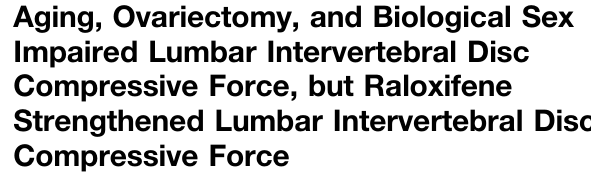
height bene fi t in female mice than in male mice, and increased nucleus pulposus area by 24% (F = 5, p < 0.05; Supplementary Figure S7 ). Compared with 24-month-old control IVD, injection of raloxifene reduced the lumbar age-related IVD degeneration score in old female mice by 57% ( p < 0.05; Figure 2B ) but did not impact the IVD height in old female mice ( Supplementary Figure S7 ).